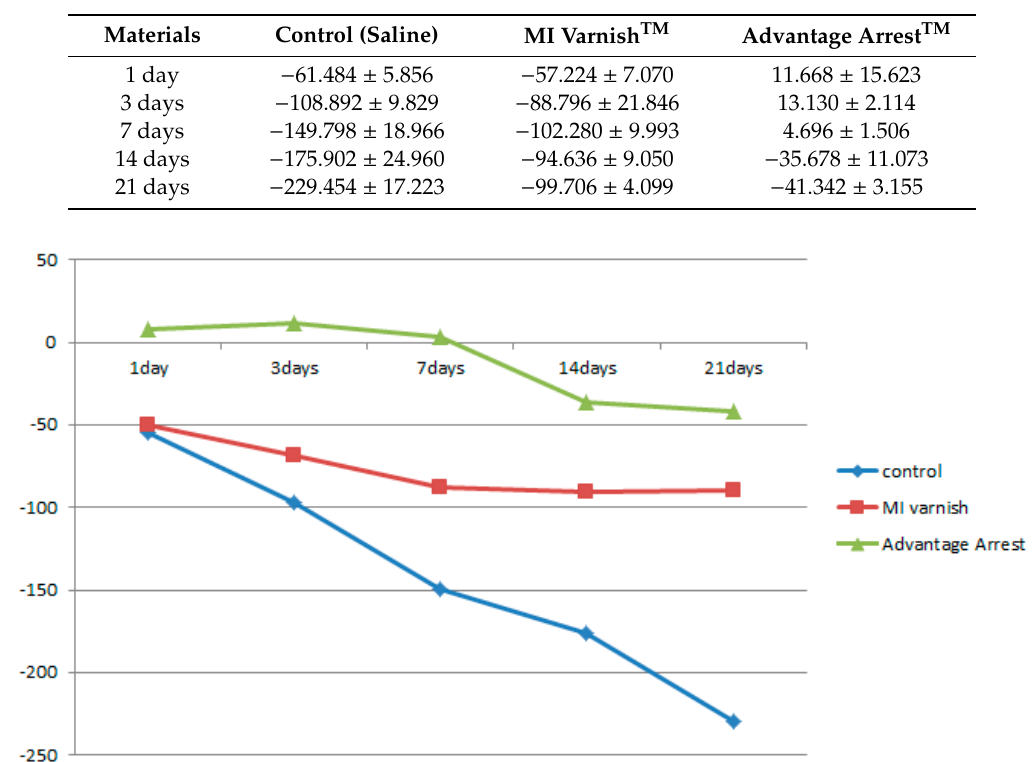
Table 4. Mean ± standard deviation of the change in enamel Hounsfield unit value at a depth of